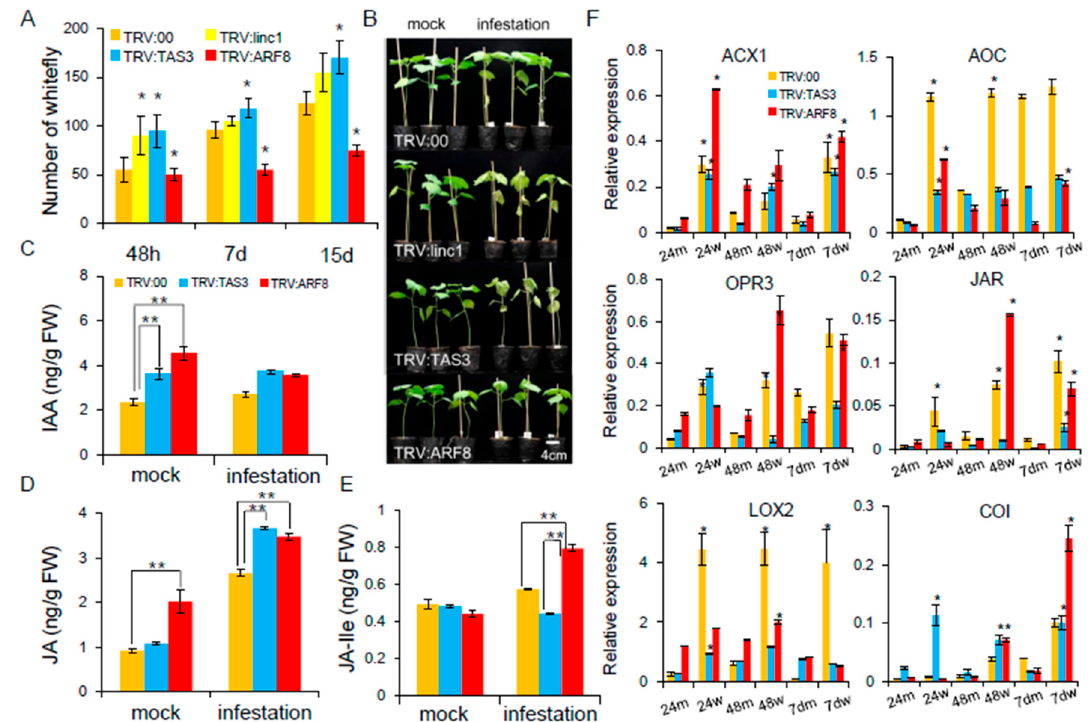
Figure 9. The auxin and JA signaling crosstalk miR390- tasiARFs involved in the cotton following whitefly infestation. ( A ) The number of whiteflies on VIGS plants. ( B ) The phenotypes of TRV:00 , TRV:TAS3 , TRV:ARF8 after whitefly infestation cotton plants at two-weeks. ( C–E ) Jasmonic acid (JA) and indole-3-acetic acid (IAA) concentrations were measured by LC-MS in TRV:TAS3 and TRV:ARF8 plants. ( F ) qRT-PCR validation of JA biosynthesis related genes after whitefly infestation VIGS plants. Error bars indicate S.D from four biological replicates. The statistical test was performed for each mock and whitefly-infested sample in in TRV:00 , TRV:TAS3 and TRV:ARF8 (Student’s t -test * p < 0.05). The 24m, 48m, 7dm, 24w, 48w, and 7dw represent mock and whitefly infestation cotton at 24 h, 48 h, 7 days, respectively.